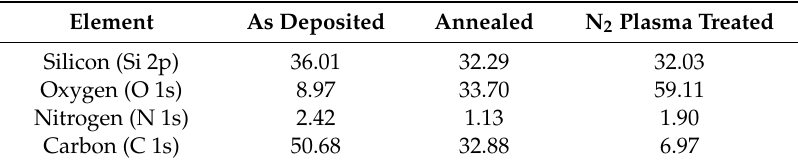
Figure 4. XPS survey scans of PECVD-deposited SiC as-deposited, after 400 °C post-deposition annealing, and after 10 min of N 2 plasma treatment. Table 1. Atomic concentration of SiC after each processing condition.